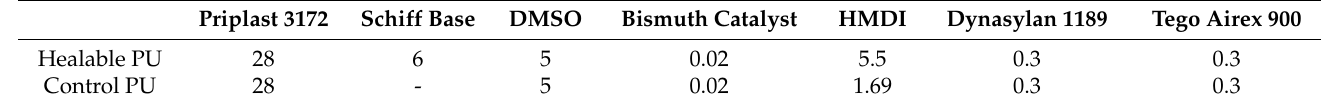
Table 1. Composition of bio-based healable and control 2K PU coatings (amounts are expressed in grams). Priplast 3172 Schiff